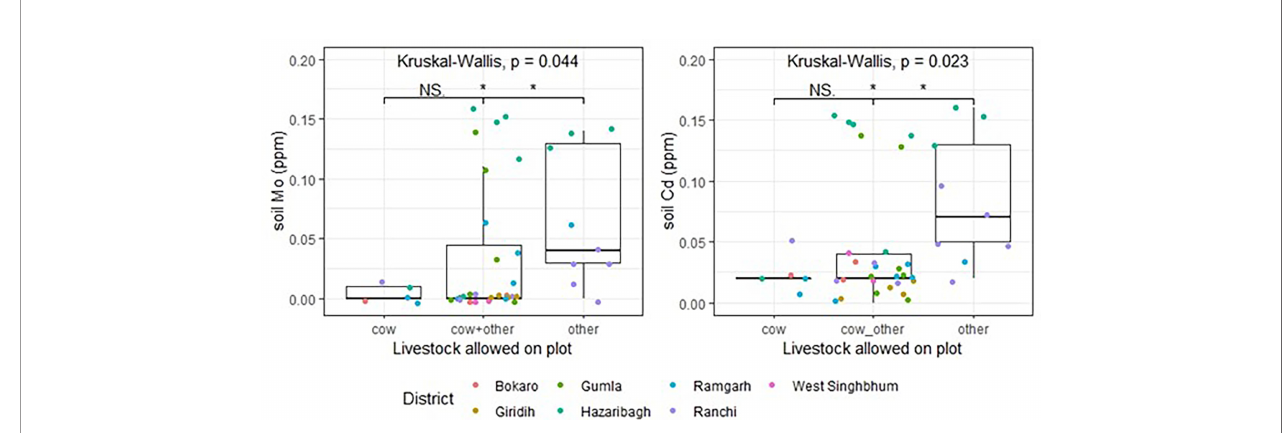
FIGURE 2 | Soil Mo and Cd distribution among livestock groups allowed on plots in fallow season. NS, not signi fi cant; * signi fi cant at the 0.05 signi fi cance